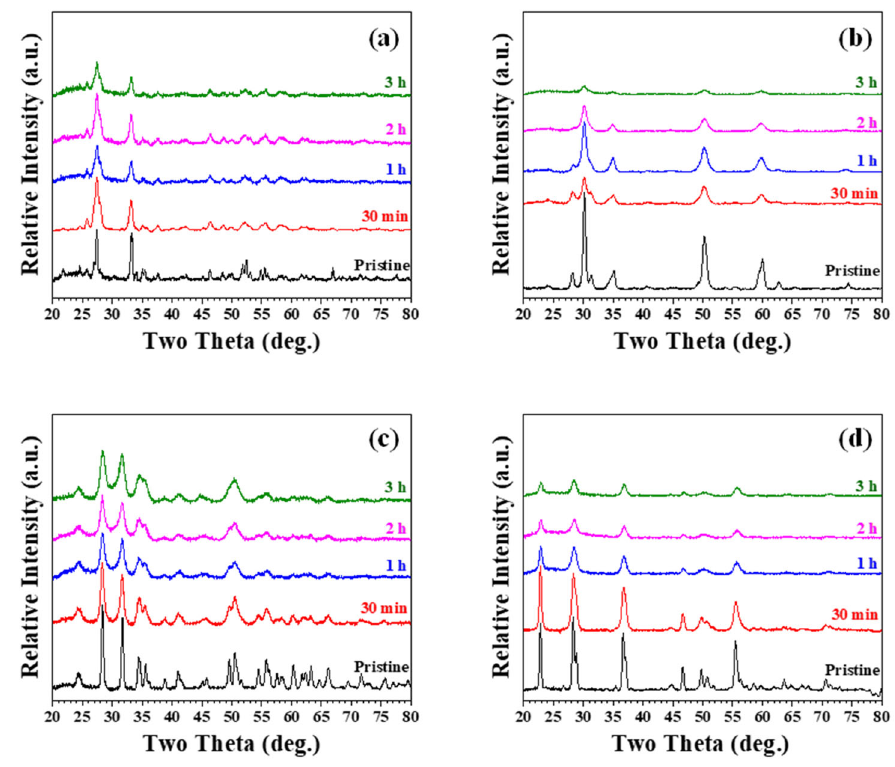
Figure 1. X ‐ ray diffraction patterns of high energy ball ‐ milled ( a ) Bi 2 O 3 , ( b ) ZrO 2 , ( c ) HfO 2 , and ( d ) Ta 2 O 5 after different milling times. Ta 2 O 5 after different milling